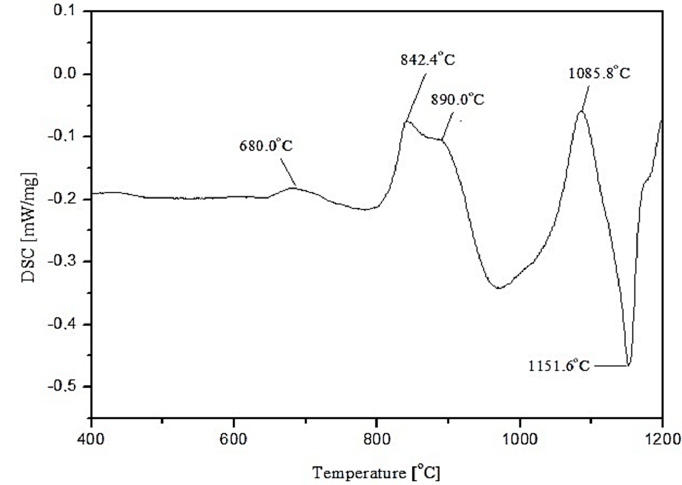
Figure 4. DSC curve of 100 wt.% amphibolite glass (Set 1*).